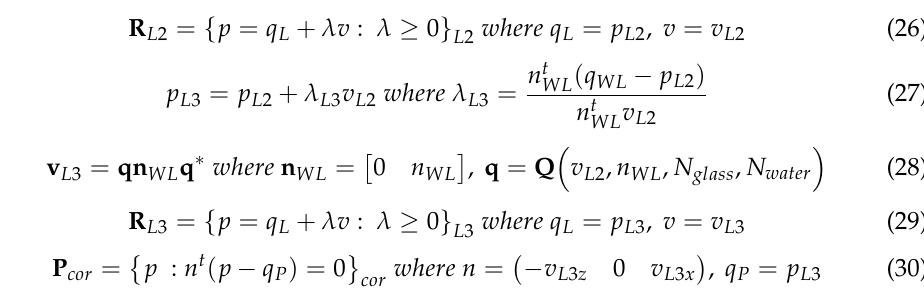
( b ) Figure 18. Obtained 3d point cloud: ( a ) in air; ( b ) in water.